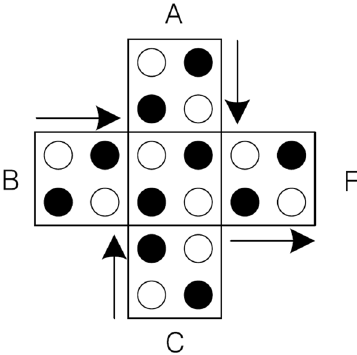
Fig. 2 The QCA implementation of three-input majority gate